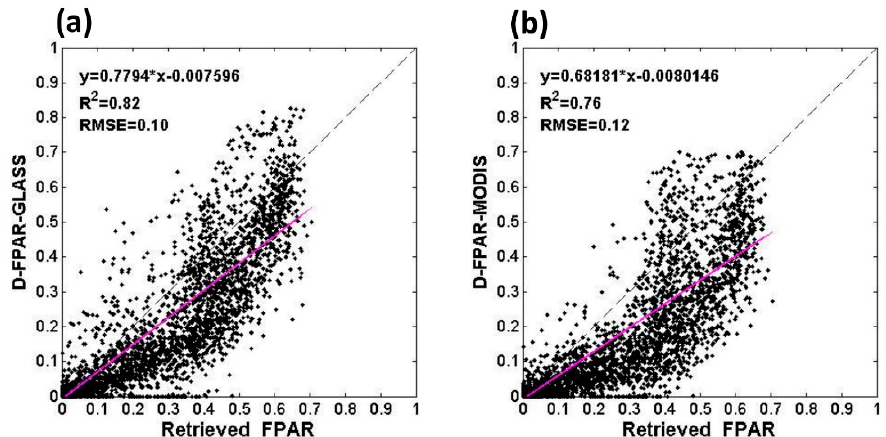
Figure 6. Validation of downscaled FPAR against retrieved FPAR in July 2012: ( a ) Comparison of D_FPAR_GLASS and retrieved FPAR; ( b ) Comparison of D_FPAR_MODIS and retrieved FPAR. Retrieved FPAR means high resolution (30 m) FPAR retrieved by using an instantaneous quantitative model based on the law of energy conservation from Chinese HJ-1B data.